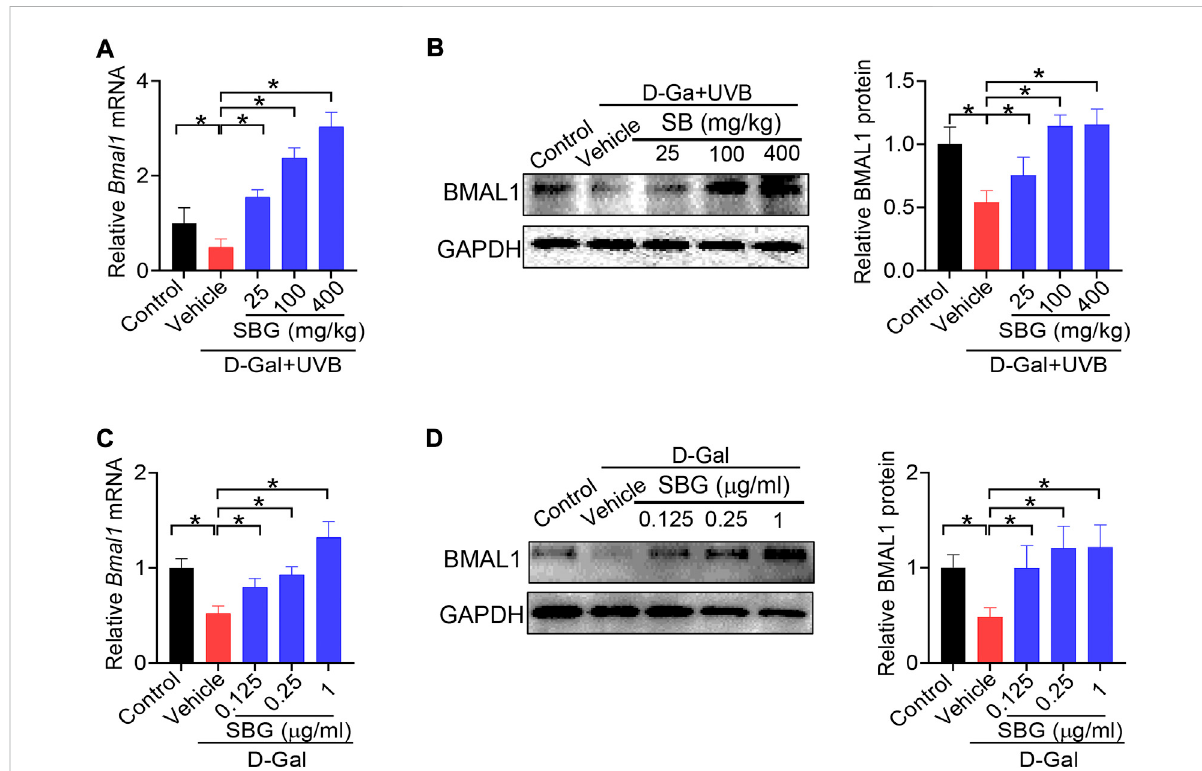
FIGURE 8 SBGup-regulates theclockgene Bmal1 inmouse andcell modelsofaging .(A) Effects ofSBGon Bmal1 mRNAintheskinofD-gal/UVB-treated mice. (B) Effects of SBG on BMAL1 protein in the skin of D-gal/UVB-treated mice. (C) Effects of SBG on Bmal1 mRNA in D-gal-treated NIH3T3 cells. (D) Effects ofSBG on BMAL1 protein in D-gal-treated NIH3T3 cells. Data are mean ± SD ( n = 7). * p < 0.05 (one-way ANOVA and Bonferroni post hoc